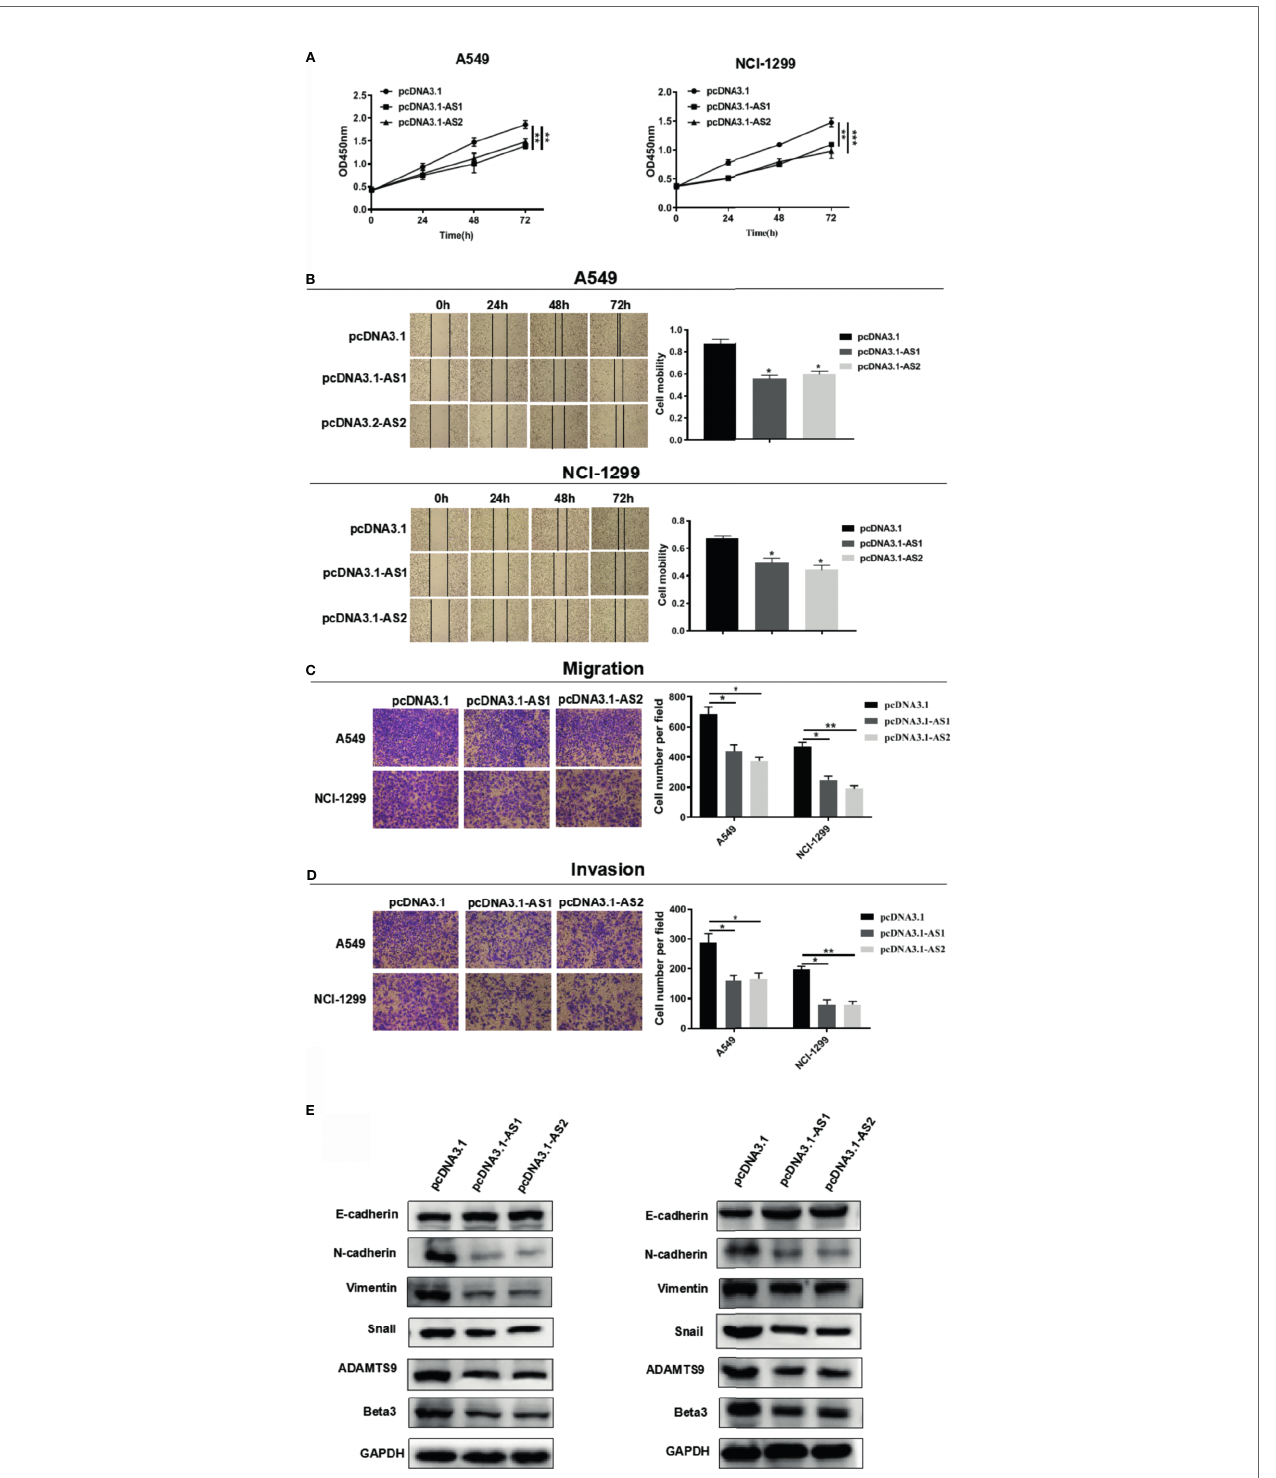
FIGURE 10 | ADAMTS9-AS1/ADAMTS9-AS2 inhibits the LUAD cells proliferation, migration and invasion. (A) The proliferative ability of ADAMTS9-AS1/ADAMTS9- AS2 was detected by CCK-8. (B) The cell healing ability of ADAMTS9-AS1/ADAMTS9-AS2 was detected by a wound healing scratch assay. (C) The migratory ability of ADAMTS9-AS1/ADAMTS9-AS2 was detected by a transwell migration assay. (D) The invasion ability of ADAMTS9-AS1/ADAMTS9-AS2 was detected by a transwell invasion assay. (E) The in fl uence of ADAMTS9-AS1/ADAMTS9-AS2 on Beta3 and EMT signal pathway detected by Western blot assays. *p < 0.05; **p < 0.01; ***p < 0.001. LUAD, lung